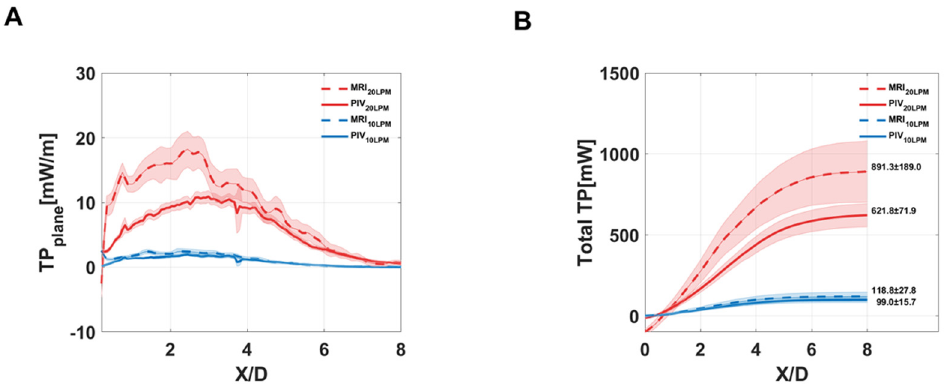
Figure 9. Planar and total turbulence production (TP) through the stenosis. ( A ) Axial directional planar TP. ( B ) Axial directional accumulative total TP.